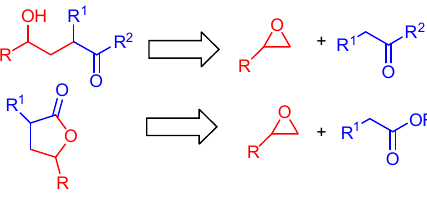
Figure 1. Retro synthesis of homoaldols and γ -lactones.